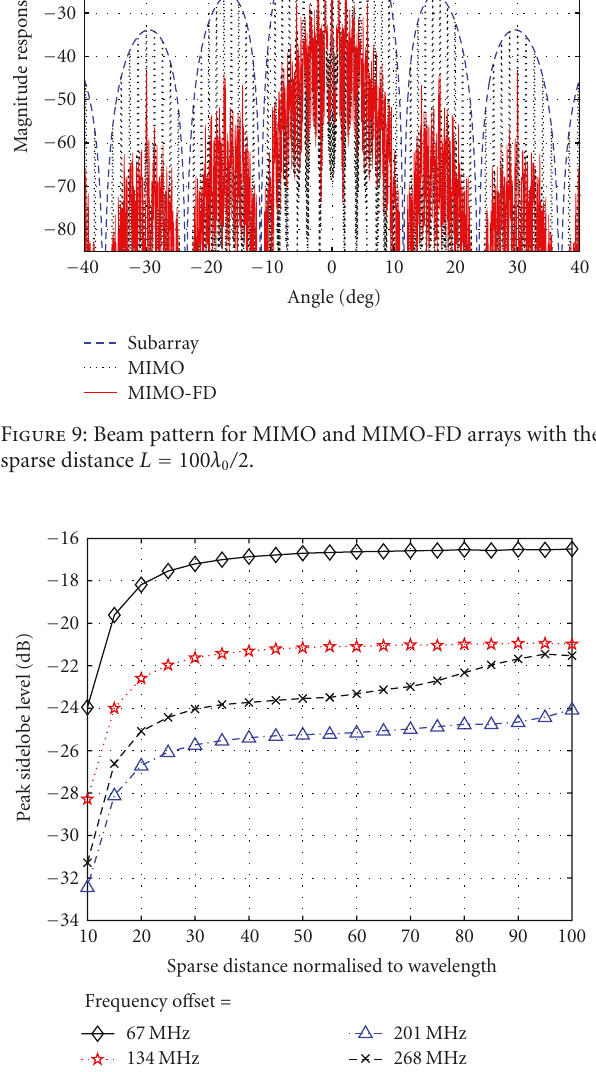
Figure 10: The PSL versus di ff erent sparse distances and frequency o ff